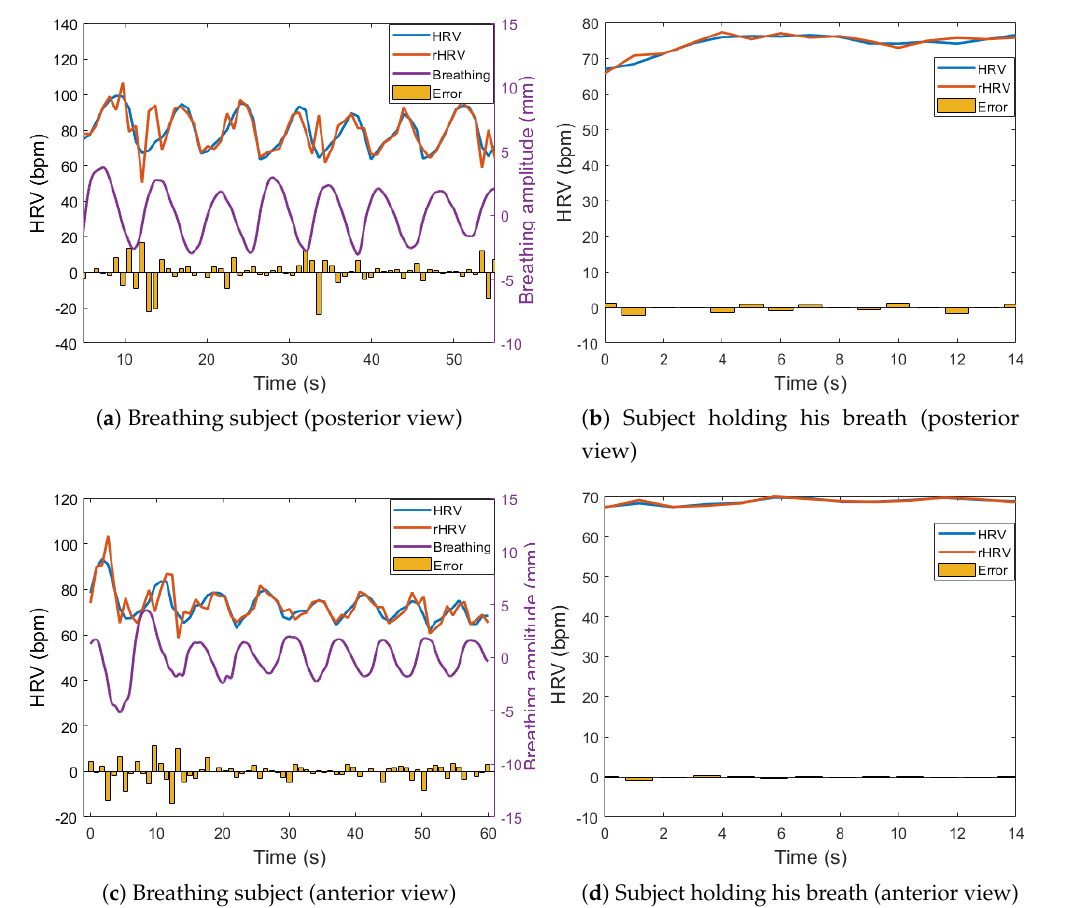
Figure 16. From top to down, for the four different scenarios: the HRV and rHRV sequences, and the error using HRV as a reference are represented as Error . In those scenarios where the subject is not holding his breath the breathing signal is displayed ( a ) Scenario 1: Breathing subject with the radar pointing towards the posterior view. The error mean is 0.21 beats/min and its standard deviation is 7.24. ( b ) Scenario 2: Subject in apnea with the radar pointing towards the posterior view. The error mean is − 0.28 beats/min and its standard deviation is 1.08. ( c ) Scenario 3: Breathing subject with the radar pointing towards the anterior view. Its error mean is − 0.17 beats/min and its standard deviation is 4.12. ( d ) Scenario 4: Subject in apnea with the radar pointing towards the anterior view. Its error mean is − 0.004 beats/min and its standard deviation is